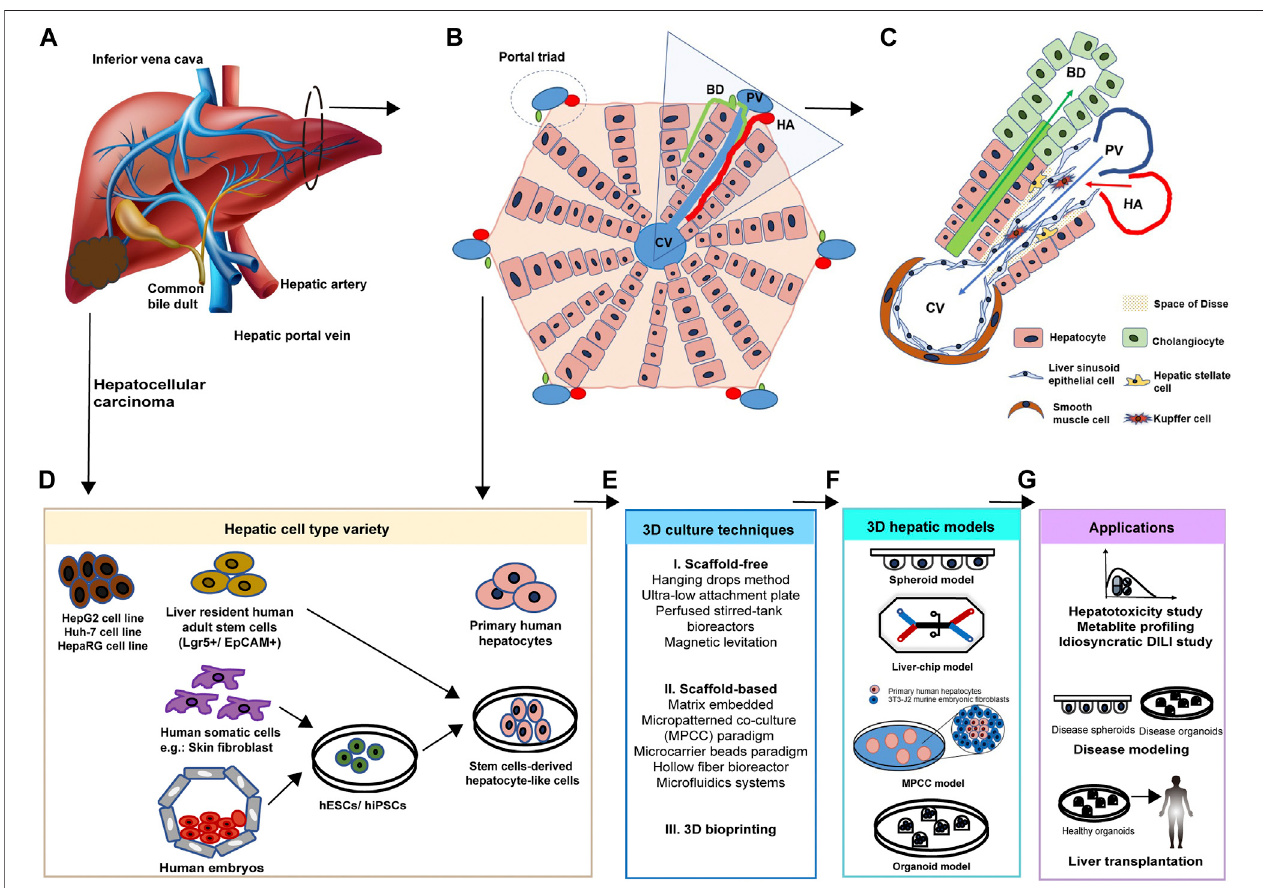
FIGURE 1 | Cellular composition of the liver. (A) Gross structure and blood supplies of the liver. The liver is a dark reddish-brown organ supplied by two distinct bloodsources:oxygenatedbloodfromthehepaticartery(HA)andnutrient-richbloodfromthehepaticportalvein(PV). (B) Hepaticlobulesarecomposedofhepatocytes arranged in linear cords radiating out from the central vein (CV) and portal triads including the bileduct (BD), HA, and PV. (C) The representative hepatic functional unit in hexagonal hepatic lobules is composed of diverse cell types. Besides parenchymal cells, non-parenchymal cells also support the hepatic structure and function. Hepatic blood vesselsare lined by specialized fenestrated liver sinusoidal endothelial cells (LSECs). Kupffer cells (KCs) are macrophages found in the sinusoids. Hepatic stellatecells(HSCs)locateinthespaceofDisse.Cholangiocyteslinethebileducts. (D) Hepaticcelltypesusedin invitro 3Dmodelscanbeobtainedfromhealthyhepatic tissue, hepatocellular carcinoma, induced somatic cells, and human embryos. (E) Advanced 3D culture techniques. Scaffold-free, scaffold-based, and 3D bioprinting techniques are applied to build 3D models. (F) Current 3D hepatic models include spheroid, liver-on-a-chip, micropatterned co-culture (MPCC), and organoids models. (G) Corresponding applications of 3D hepatic models derived by various cell types. Developed diseased or healthy 3D models are promising in the areas of hepatotoxin screening, idiosyncratic drug reaction study, diverse disease modeling, and hepatocyte transplantation.